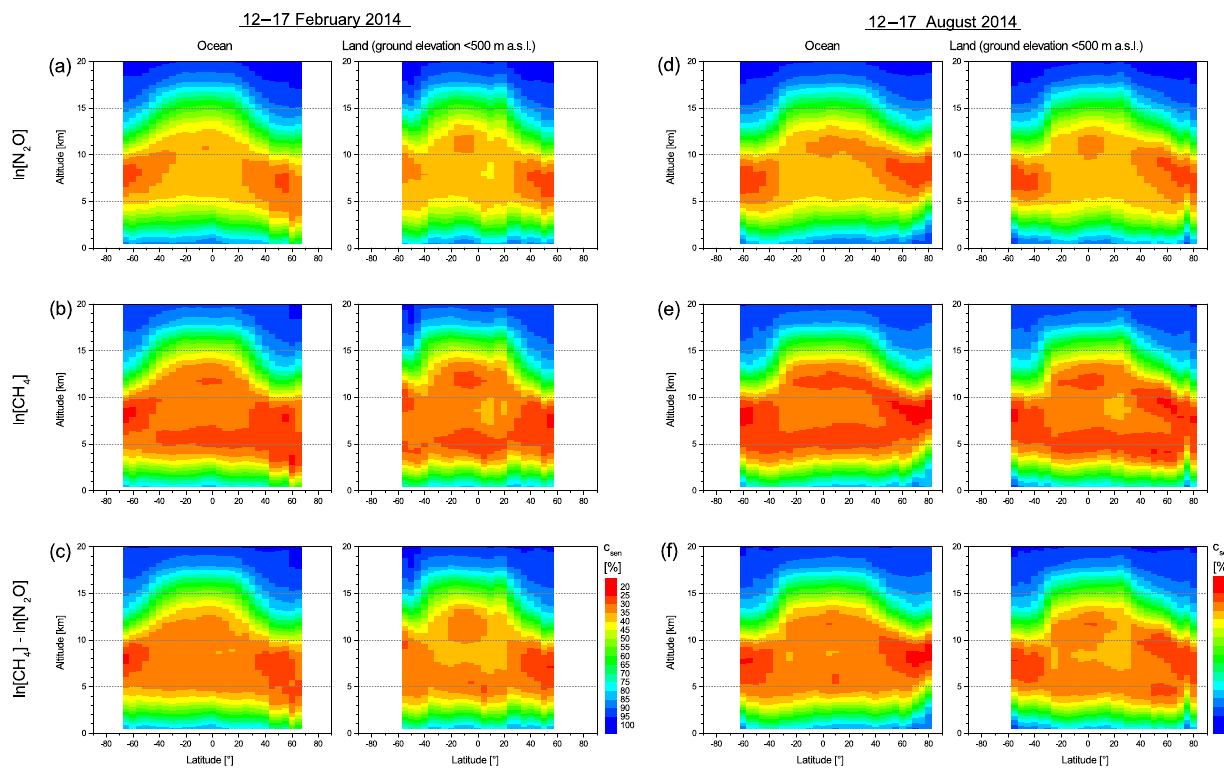
Figure 4. Latitudinal cuts of the vertical dependency of the sensitivity (defined as c sen values according Eq. 18): (a–c) for mid-February and the products ln [ N 2 O ] , ln [ CH 4 ] and ln [ CH 4 ]− ln [ N 2 O ] , respectively; and (d–f) for the same products, but for mid-August. The latitudinal cuts are shown separately for observations over ocean and land (only if ground altitude < 500ma.s.l.). Table 3. List of uncertainty assumptions used for the error